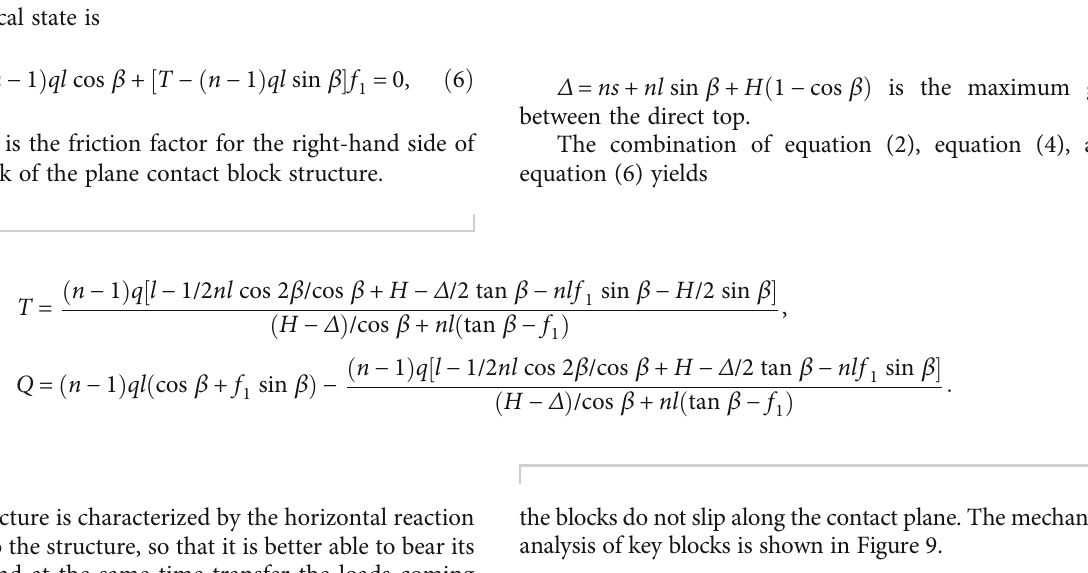
Figure 9: Mechanical analysis of key